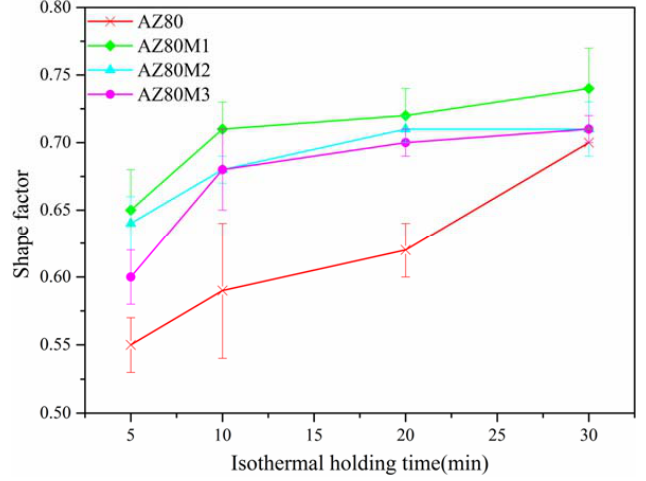
Figure 8. Effect of Y addition on the shape factor at 570 °C for different isothermal holding times.